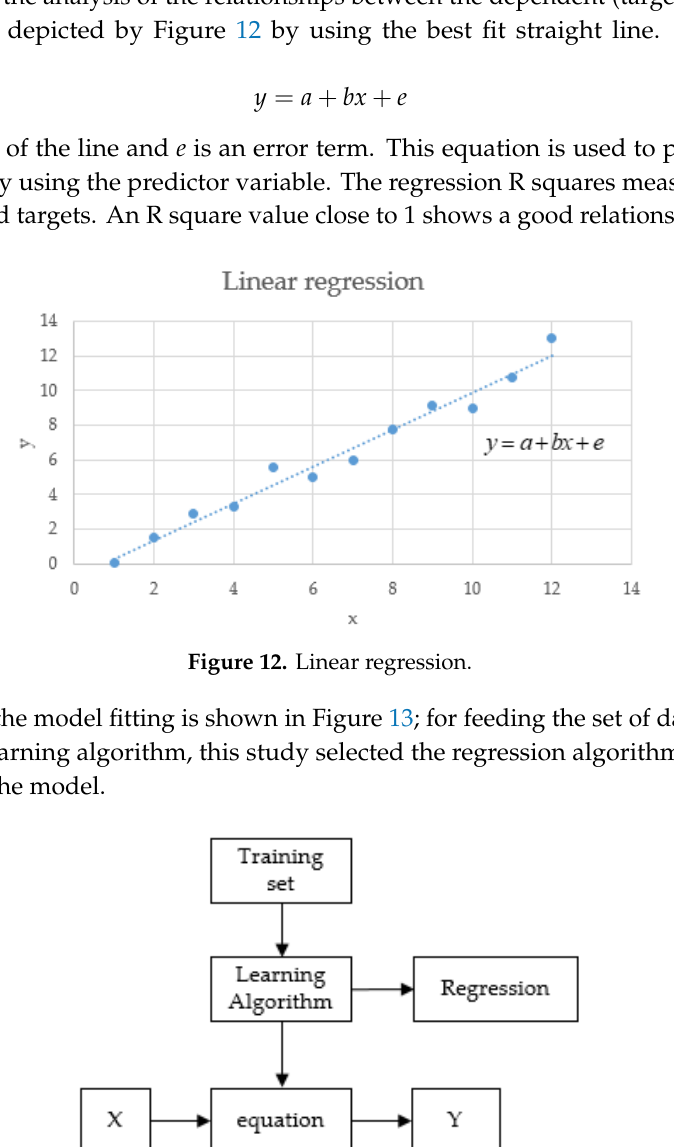
Figure 13. Process flow of model fitting.